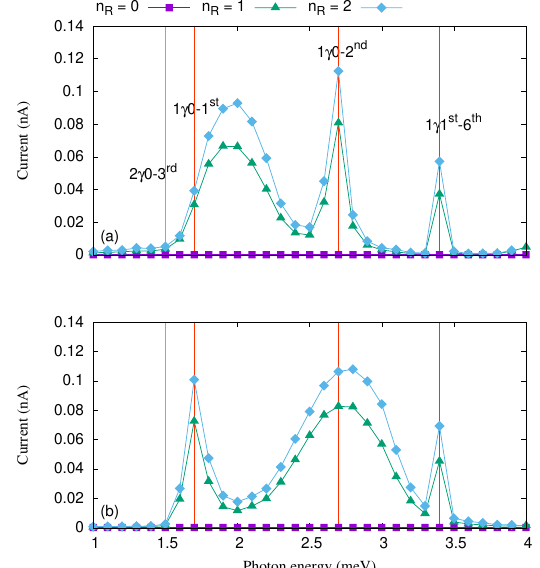
Figure 3. Current versus the photon energy is plotted for the photon number n R = 0 (purple squares), 1 (green triangles), and 2 (blue diamonds) in the case of x - ( a ) and y -polarized ( b ) photon field with g γ = 0.1 meV, and κ = 10 − 5 meV. The vertical red lines indicates the positions of the resonance states. The chemical potential of the left lead is µ L = 1.65 meV and the right lead is µ R = 1.55 meV. The external magnetic field is B = 0.1 T, eV g = 0.651 meV, T L,R = 0.5 K, and ¯ h Ω 0 = 2.0